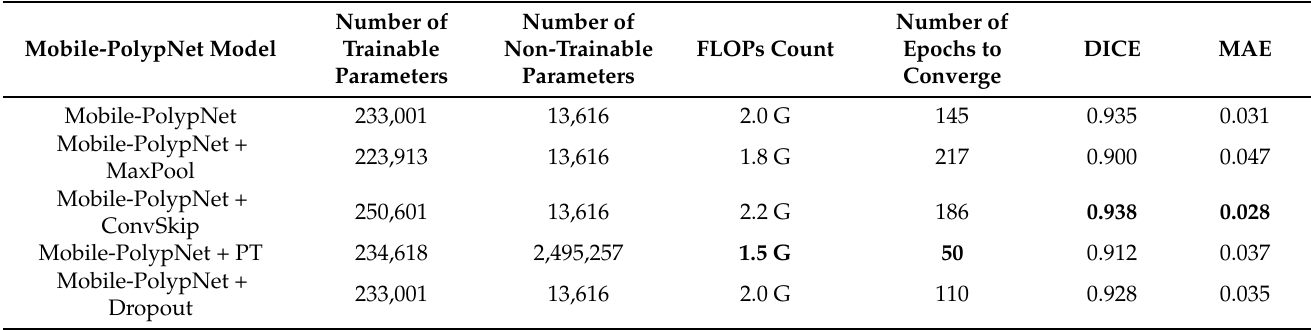
Table 4. Computation and accuracy performance comparison of different modified models based on the same Mobile-PolypNet backbone architecture on the Kvasir dataset. FLOPs have been calculated for an image dimension of 224 × 224. The bold is to identify the best of the